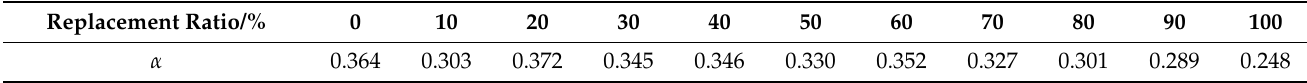
Figure 11. Strength development model of RAC: ( a ) the model of the fitting and ( b ) strength coefficient fitting. Table 4. The parameters of